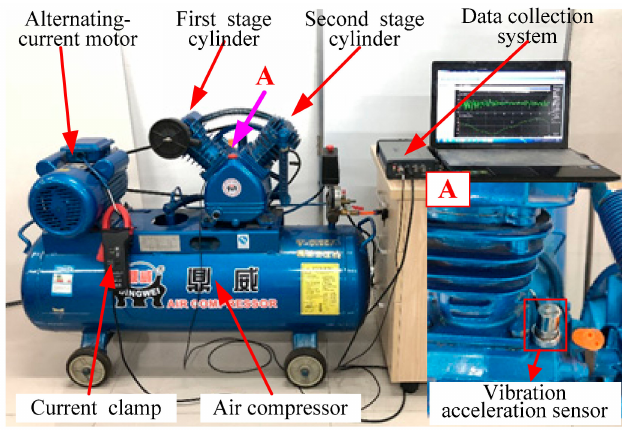
Figure 6. Experimental test-rig for RC valve